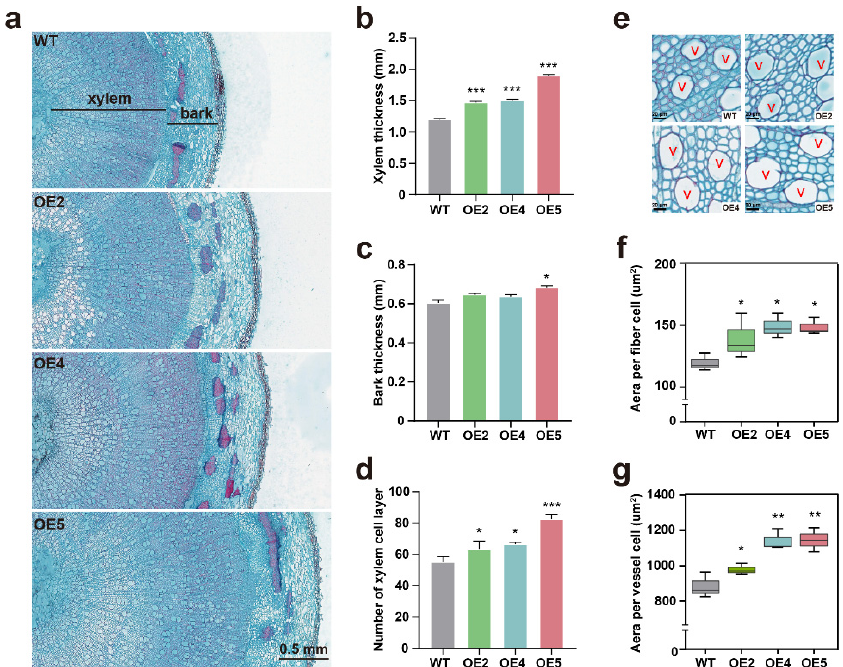
Figure 4. Anatomic analysis of stem growth and development of wild type and PtGSTF1 transgenic plants. Four-week-old plants at the same size and growth state propagated on MS medium were transferred to soil and grown in a greenhouse under the same environmental conditions for 12 weeks. ( a ) Cross sections of stems showing increased xylem area in transgenic plants. ( b , c ) Xylem and bark thickness. ( d ) Xylem cell layer numbers. ( e – g ) Quantification of the size of fiber and vessel (V) cells. Images were captured on toluidine blue-stained anatomical sections. The area of fiber and vessel cells was measured and calculated via IMAGEJ based on the images. WT, wild type; OE2, OE4 and OE5, different transgenic lines. Values are means ± SD of 200 fiber or vessel cells from three plants of WT and each PtGSTF1 transgenic line, respectively. *, p < 0.05; **, p < 0.01; ***, p < 0.001.